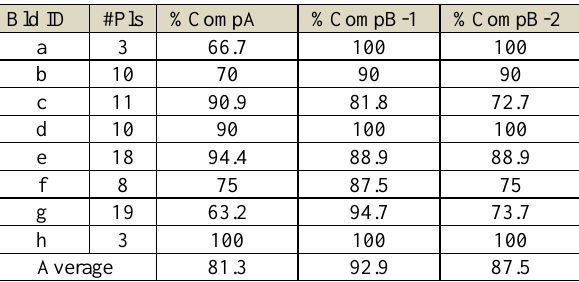
Table 1. Completeness of reconstructed roof models. Bld ID: